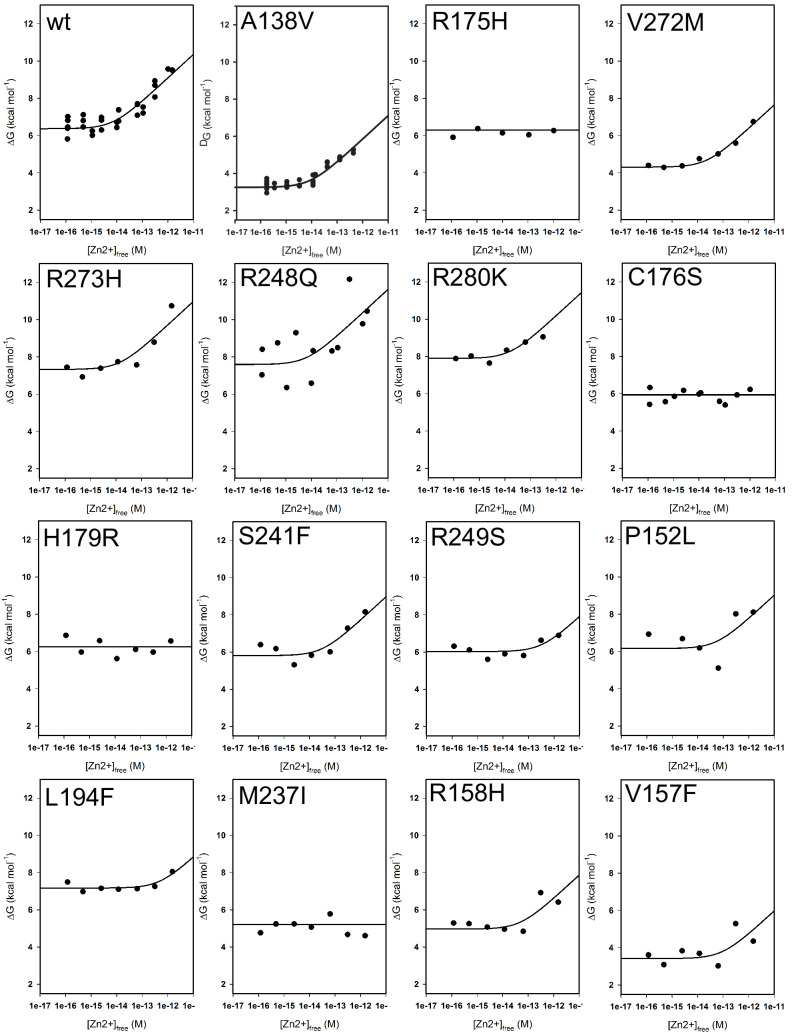
Free energy of folding versus buffered [Zn2+]free for p53 DBD mutants.Folding energies were determined from guanidine melts of DBD mutants in EDTA-buffered [Zn2+]free, and were used to determine the zinc-free folding energies and zinc affinities presented in Figures 3C and 4. Independent experimental results were pooled and fit to Equation 3 to obtain ΔGapo and KZn, which are reported in Figure 3—source data 1 with the standard errors of the fit. No data points were rejected in any of the plots.